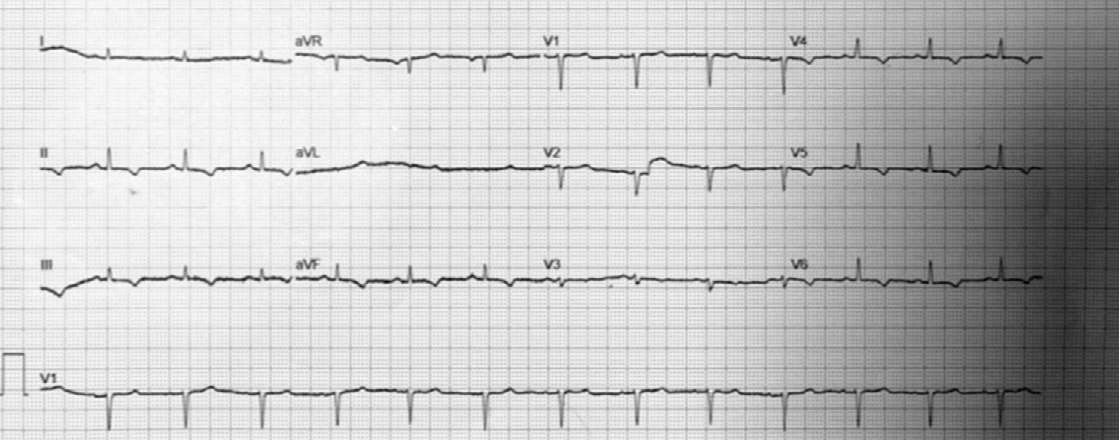
Figure 2. 12-lead ECG showing sinus rhythm and repolarization abnormalities in inferior leads, in absence of PR interval depression or other signs of pericarditis.